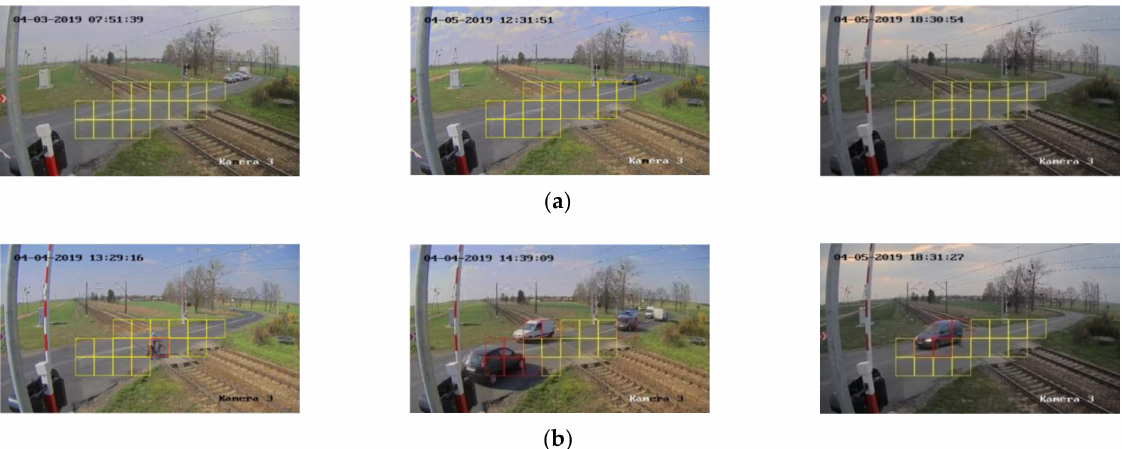
Figure 6. RLC state ( a ) “safe passage for trains”, ( b ) “with objects”. Red edges signify that the square contains